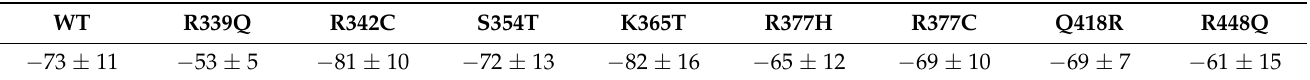
Table 1. Average binding energy in kcal/mol calculated for each CTCF–DNA complex over the last 100 ns of simulation for each of the five trajectories per system.